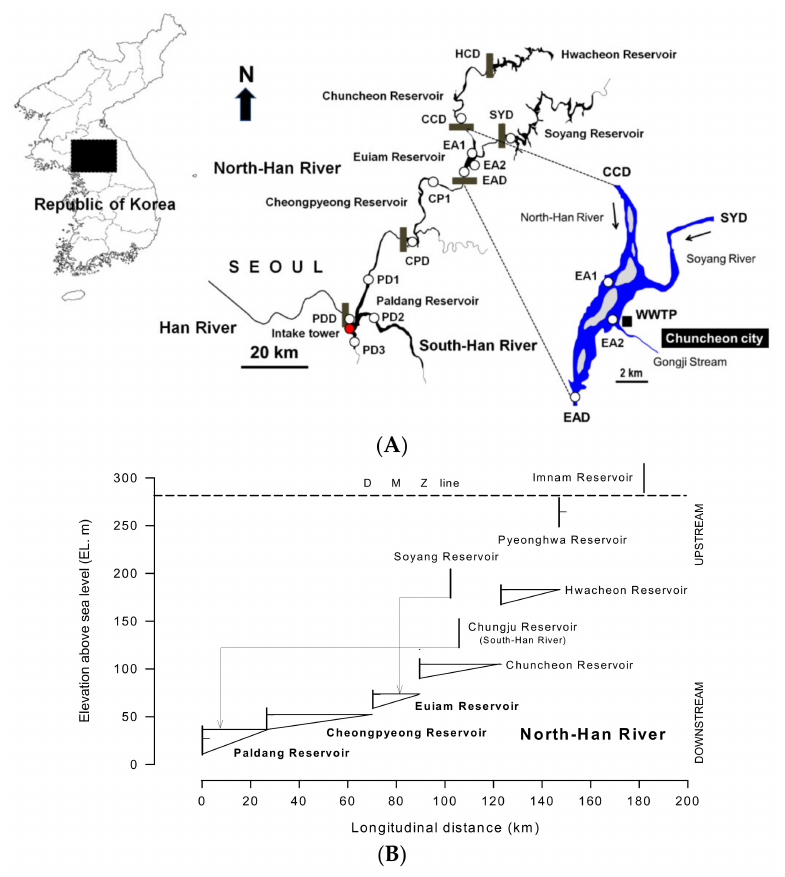
Figure 1. ( A ) Map and ( B ) schematic diagram showing the sampling stations and target study area (Euiam–Paldang Reservoirs) located in the North Han River and Han River system. Field study and data used were from January to December 2011. The EA2–EAD stations in Euiam Reservoir were additionally surveyed on 13 August and 19 September 2011. HCD, Hwacheon Reservoir dam; CCD, Chuncheon Reservoir dam; SYD, Soyang Reservoir dam; EAD, Euiam Reservoir dam; CPD, Cheongpyeong Reservoir dam; PDD, Paldang Reservoir dam; WWTP, wastewater treatment